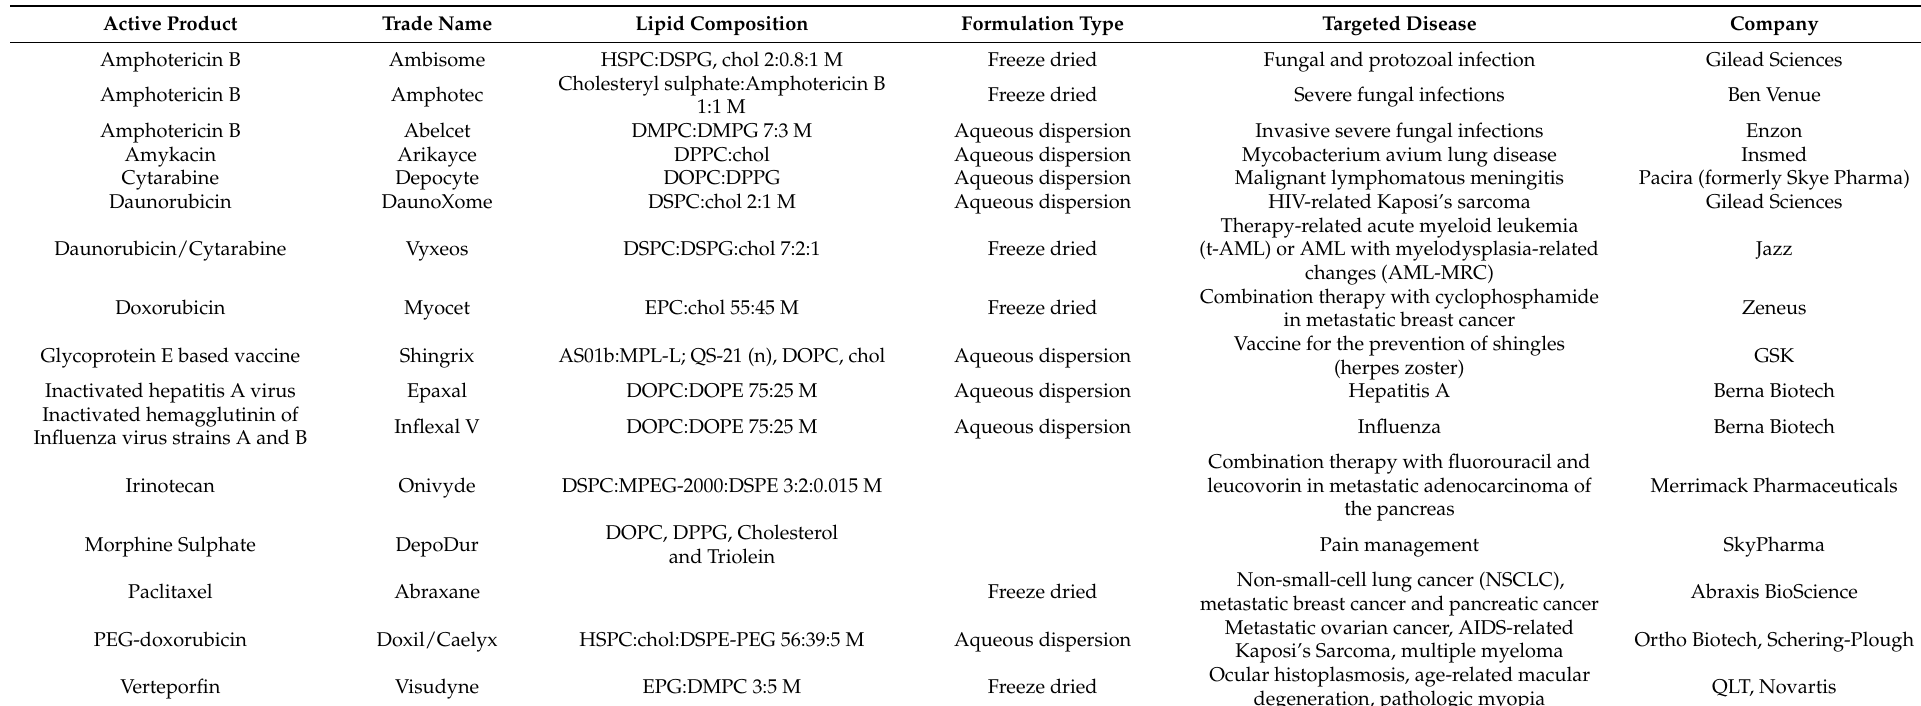
Table 1. A table indicating typical FDA approved and marketed liposomal products